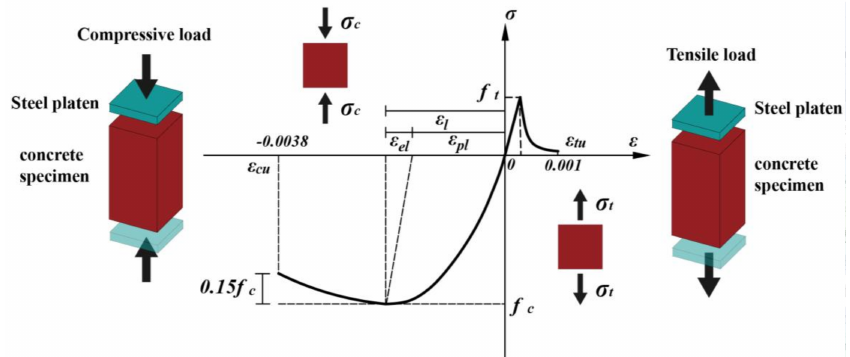
Figure 3. Hognestad model [40] and Mazars model [41] of the cement-based materials that were used in the